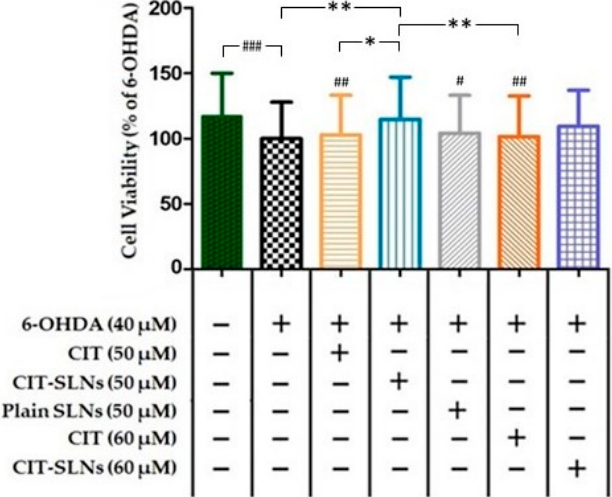
Figure 6. Measurement of percentage of SH-SY5Y viable cells by WST-8/CCK8 assay. The results are expressed as the mean ± standard deviation; n = 5, * p < 0.05, ** p < 0.01, # p < 0.05 vs. no-treatment control, ## p < 0.01 vs. no-treatment control, ### p < 0.001 vs. no-treatment control. (See Excel Sheet S2 in Supplementary Materials for the original raw